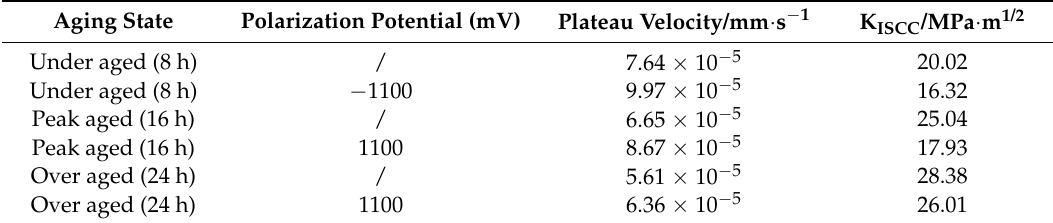
Table 2. The SCC susceptibility of 7050 aluminum alloy immersed in 3.5% NaCl